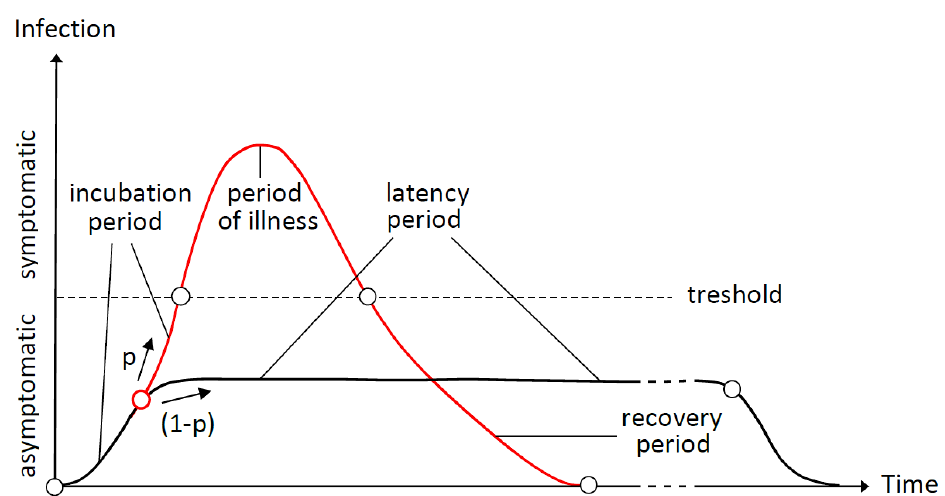
Figure 1. Symptomatic and asymptomatic pathways of interaction with infection. The bifurcation point is shown with a red circle. After that, there is transition either to the symptomatic state with probability 𝒑 or to the asymptomatic state with probability (𝟏 − 𝒑) . In the first case (red line), the infected persons go through the incubation period , period of illness and recovery period . In the second case (black line), they only go through the latency period